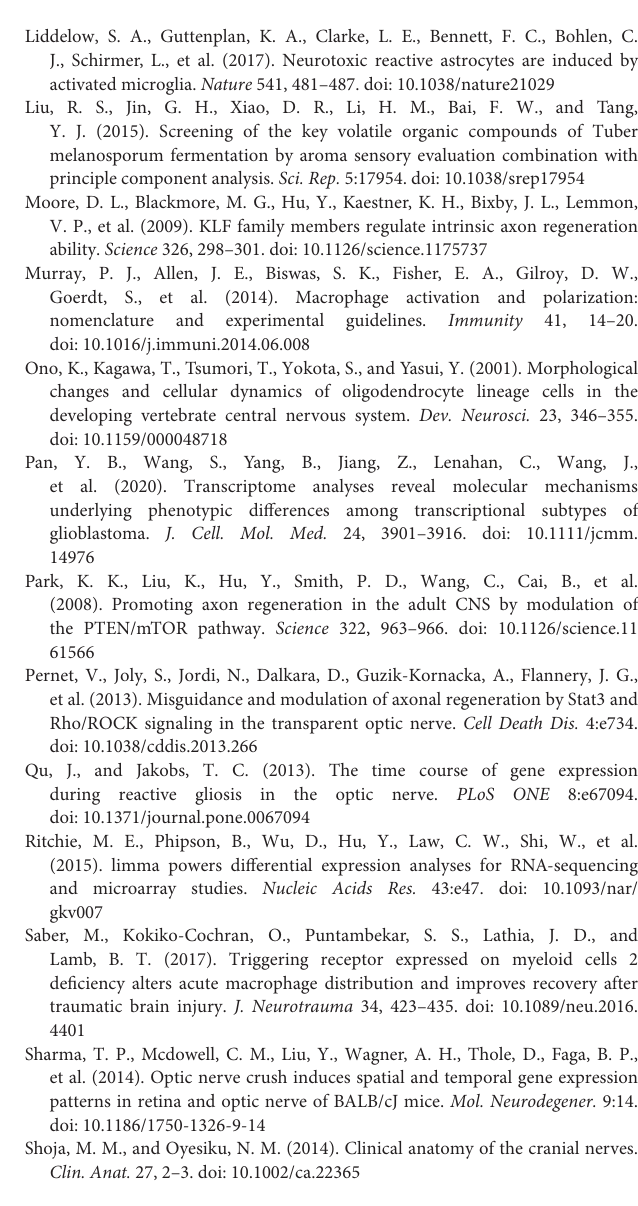
Supplementary Figure S2 | Hierarchical clustering of the 45 ONHs based on all gene profiles. ONH, optic nerve head. Supplementary Figure S3 | Differentially expression analyses of injured ONHs 1/3/7/21d post-ONC. (A) Based on different threshold conditions (logFC), the numbers of DEGs at each time point of ONC were shown. (B–E) Volcano plot of DEGs in ONHs 1/3/7/21d post-ONC compared with uninjured control ONHs. Red points represent DEGs. DEG, differentially expressed gene; ONC, optic nerve crush; ONH, optic nerve head. Supplementary Figure S4 | Cell type enrichment analyses for M1-M5 modules. (A–E) Cell type enrichment analyses for M1-M5 modules.